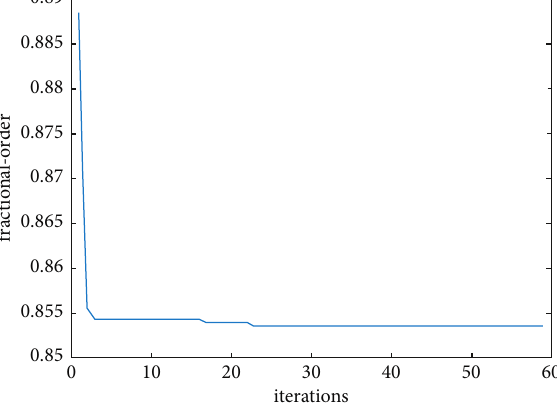
Figure 3: Fractional-order convergence